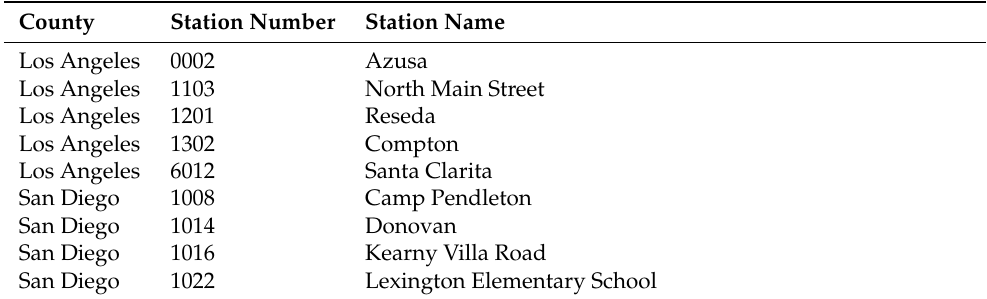
Table 2. Overview of the stations used for the comparison of model results and observations.